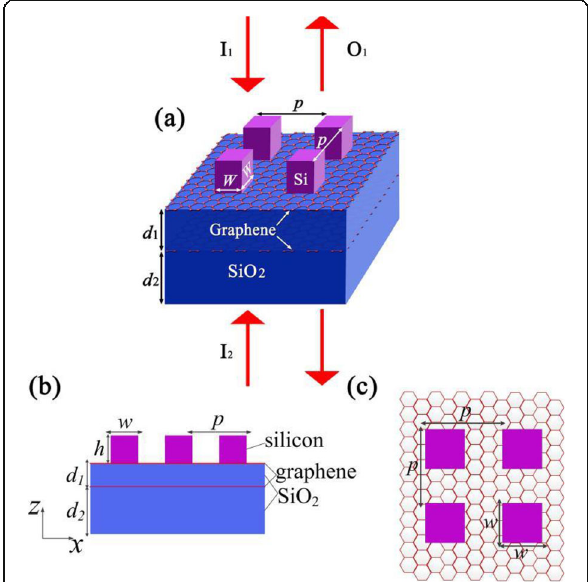
Fig. 1 a Schematic diagram of the dual-band graphene-based perfect absorber. b Side view with dimensions specified. c Top view with dimensions